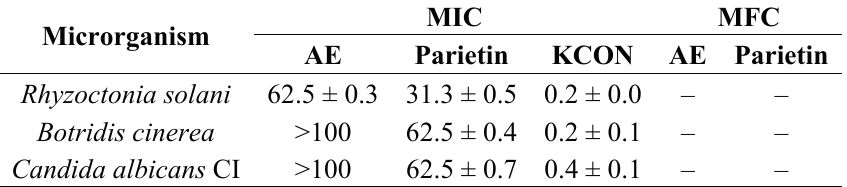
Table 2. Antifungal activity (MIC values µg/mL) of acetone extract (AE) from Xanthoria parietina and parietin.